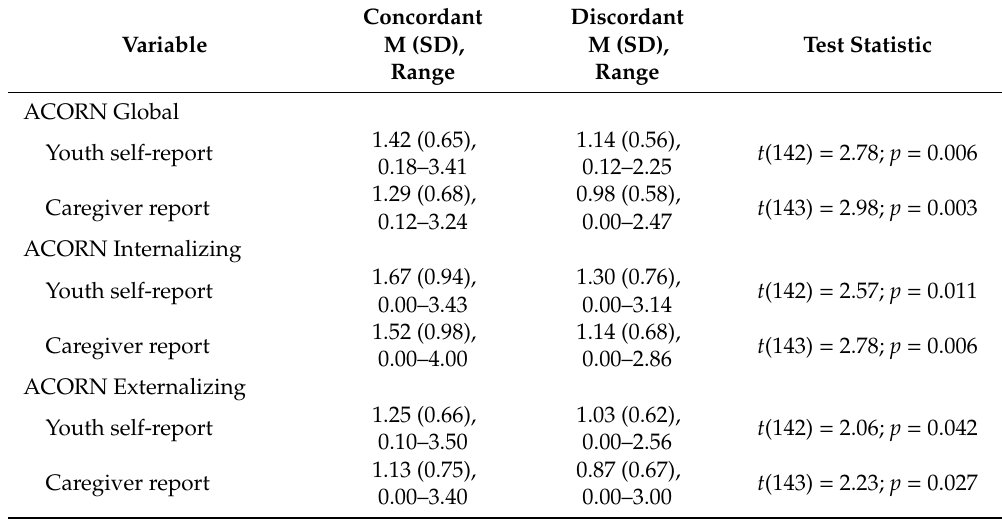
Table 2. Descriptive statistics for symptom scores by reporter and youth–caregiver primary